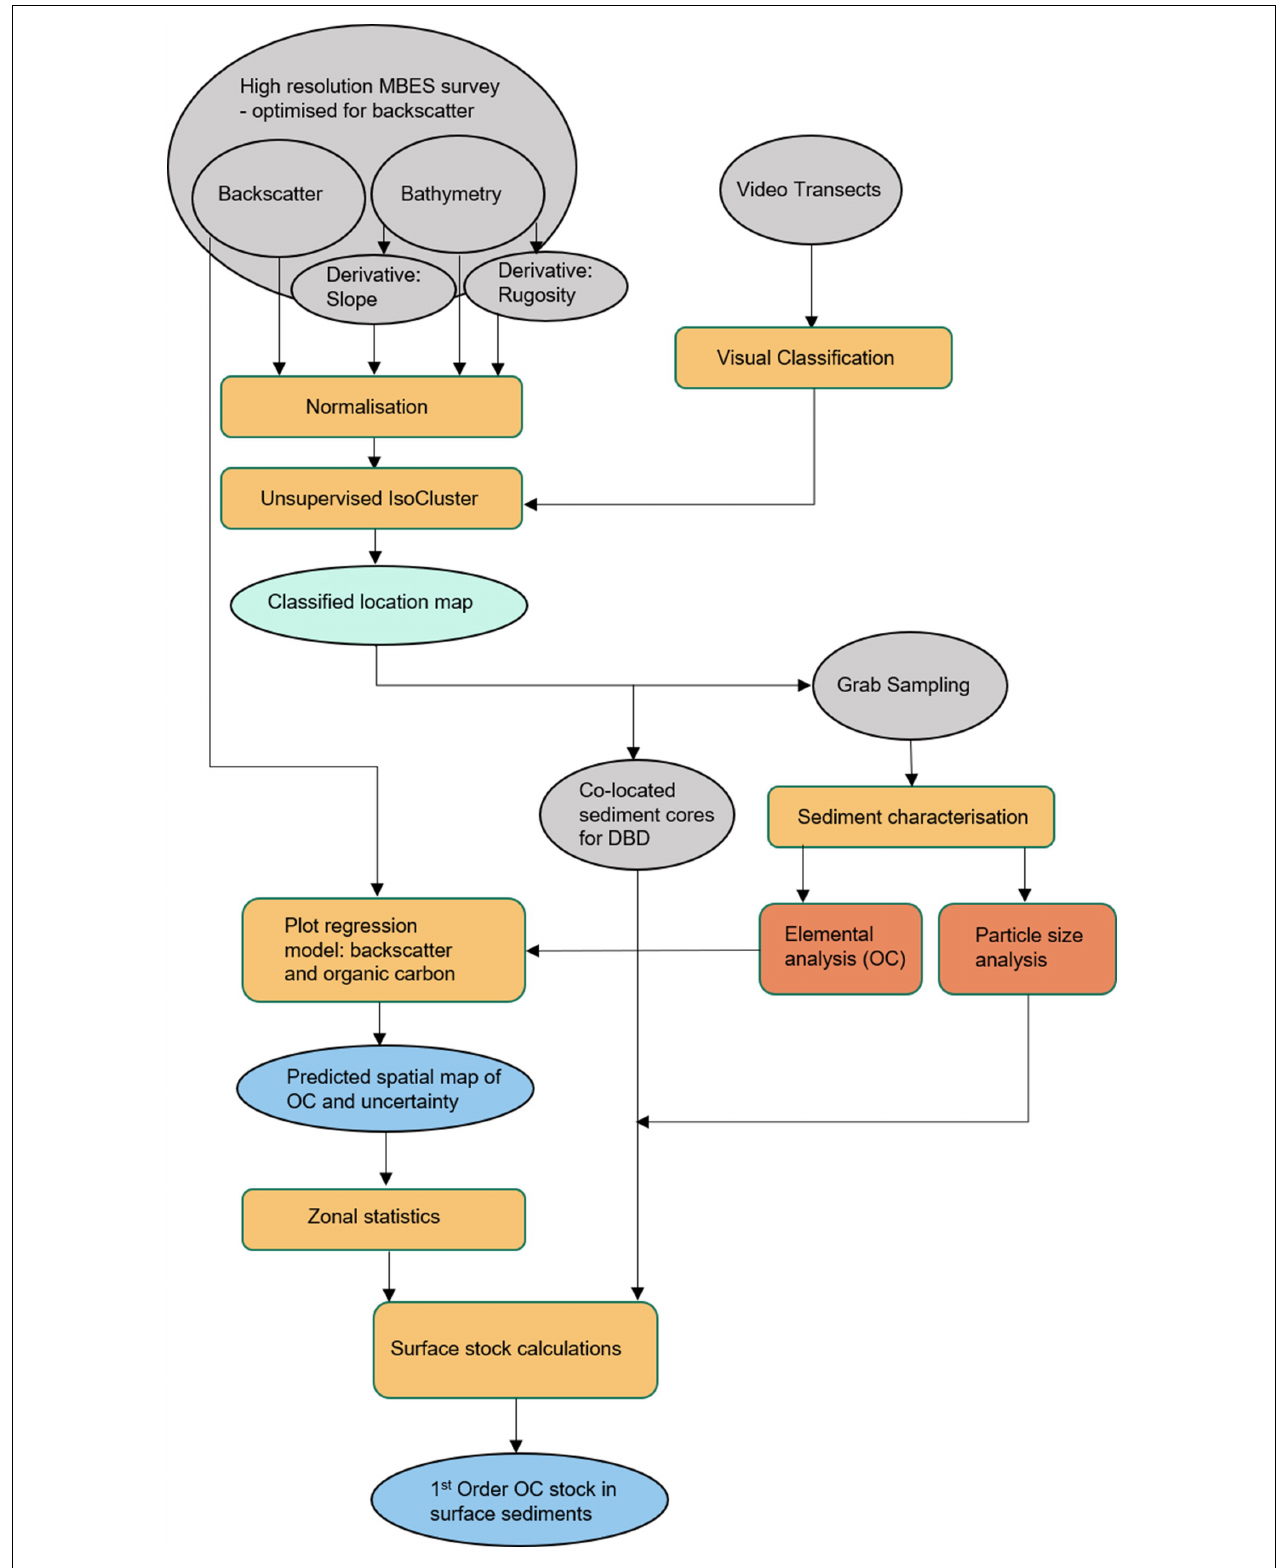
FIGURE 11 | Schematic of our applied methodology which adapts existing benthic mapping tools to produce high spatial resolution maps for organic carbon within surface sediments. Key: Grey – sample collection; Yellow – processing step; Green – intermediary output; Orange – sediment characterisation; Blue – primary output.